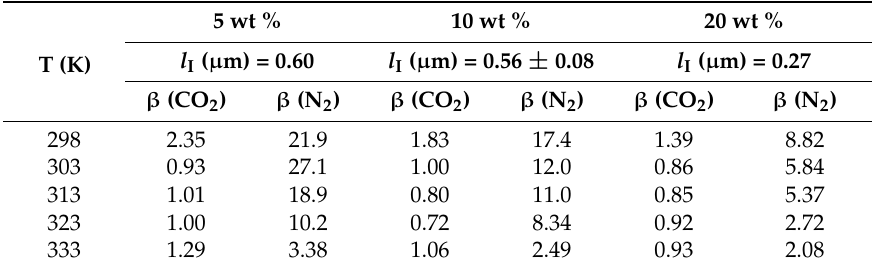
Parameters estimated by the reduced mobility modified Maxwell model for the LTA/PTMSP MMMs.